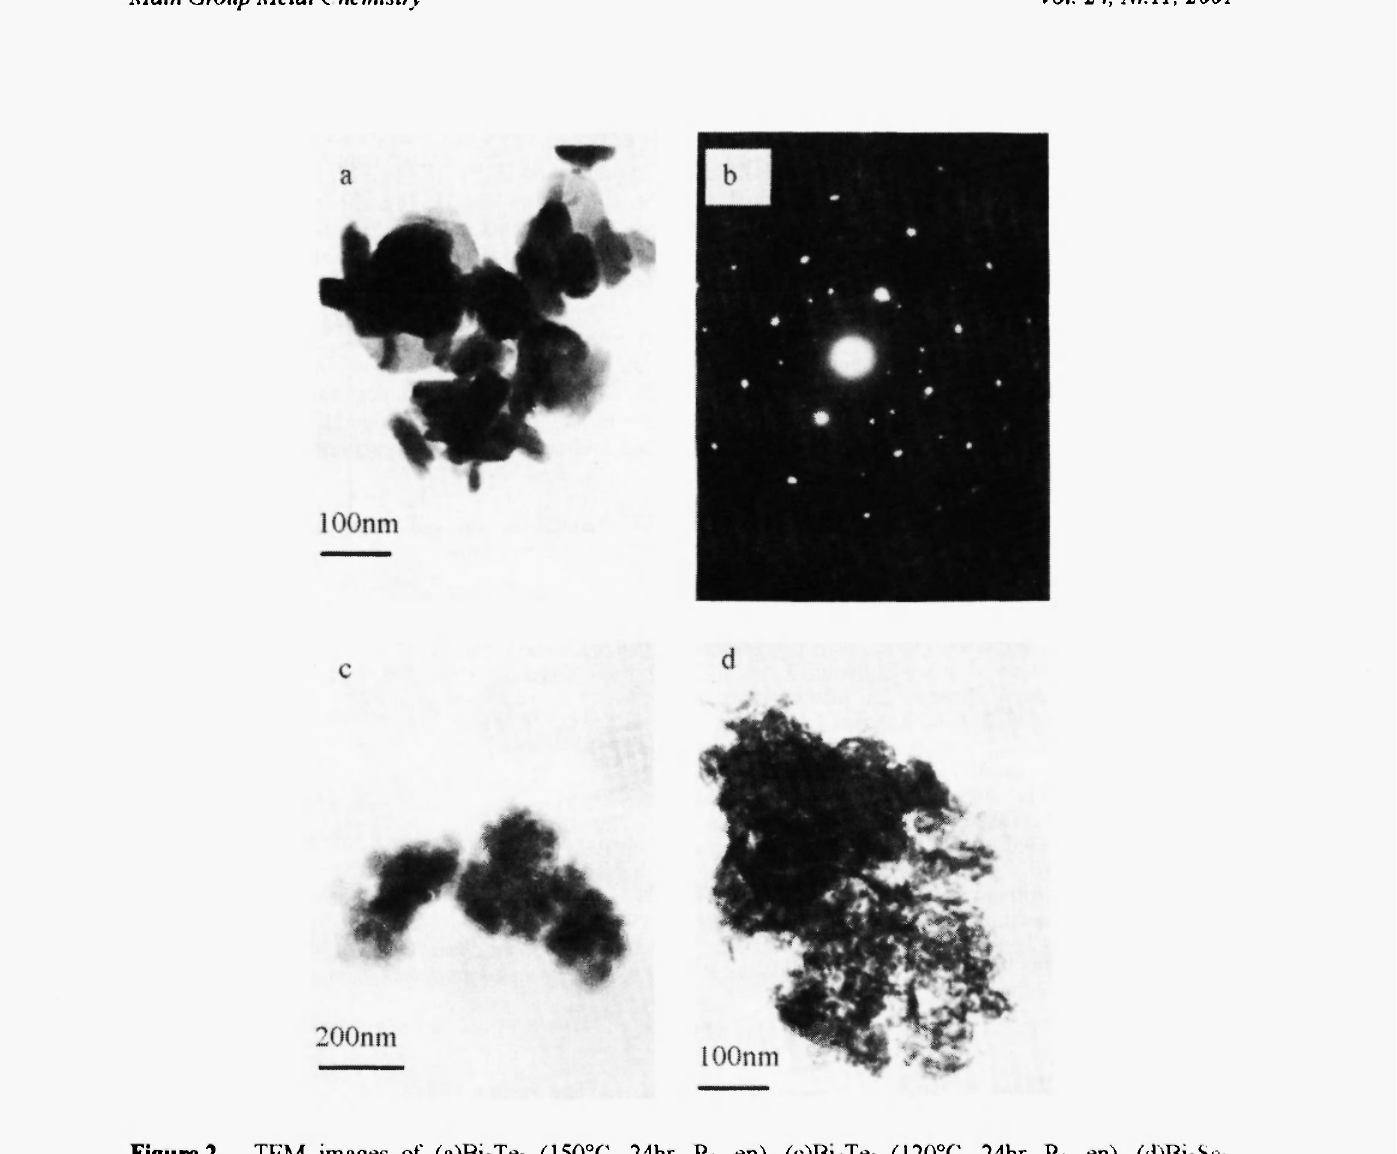
Figure 2. TEM images of (a)Bi : Te, (150°C, 24hr. P 4 , en), (c)Bi^Te, (120°C, 24hr, P 4 , en), (d)Bi : Se-. (100°C, 24hr, hydrazine, en) and SAED pattern of (b) Bi : Te, (150°C, 24hr, P.,,